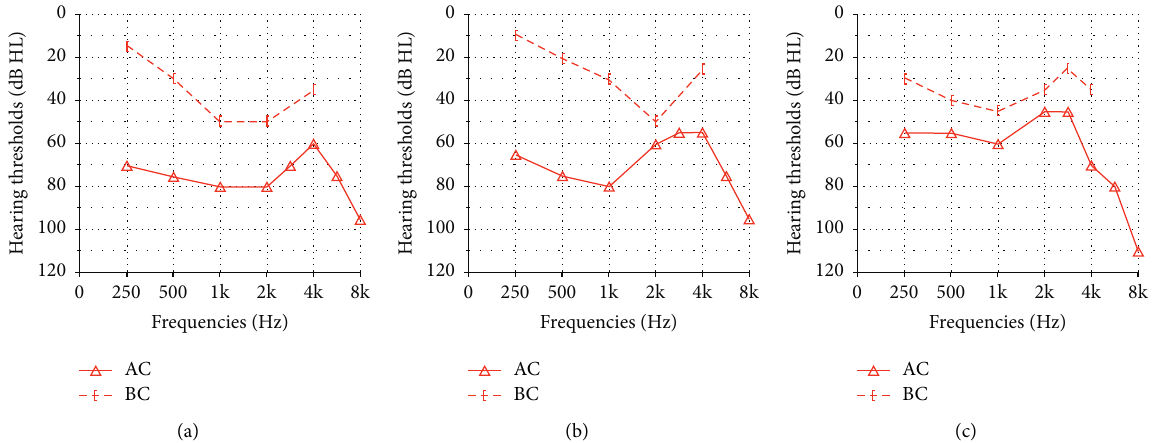
Figure 2: Pure-tone audiometric results preoperation (a), postoperation (b), and after revision surgery (c). AC, air conduction thresholds; BC, bone conduction